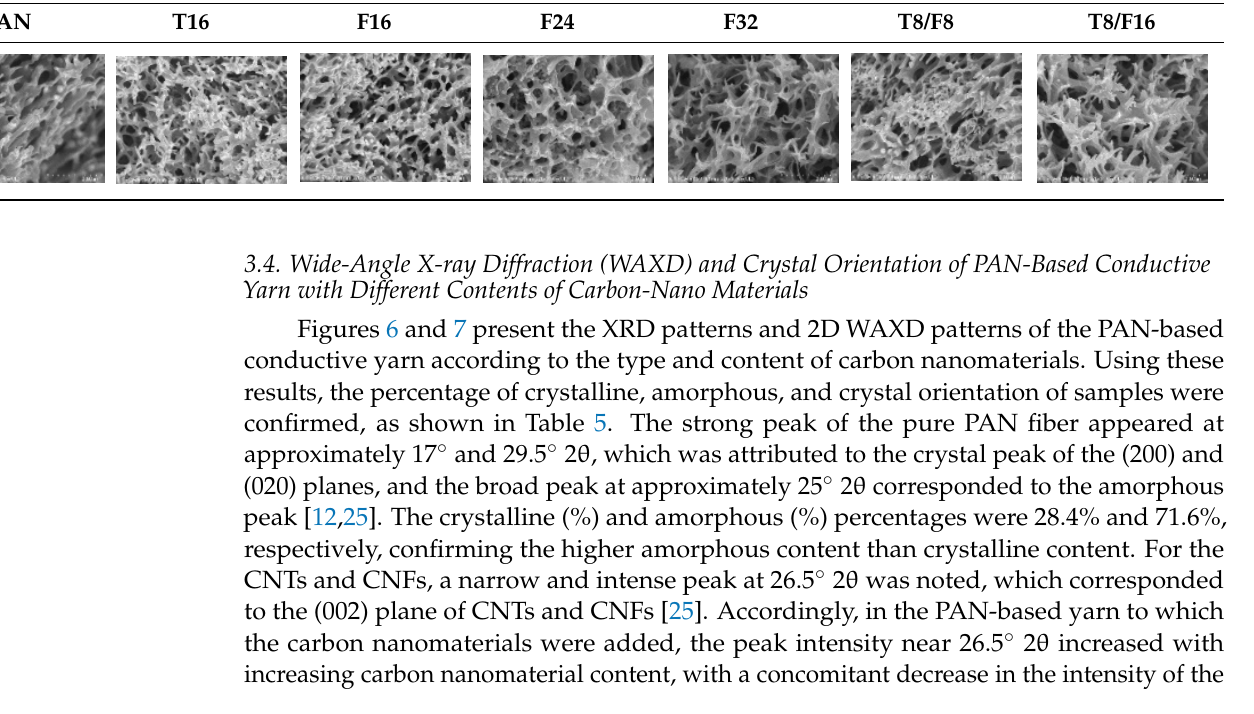
Table 6. Morphology of the PAN-based conductive yarn with different contents of carbon nanomaterials ( × 20,000). Contents of Carbon Nanomaterials in PAN-Based Composite (wt%) PAN